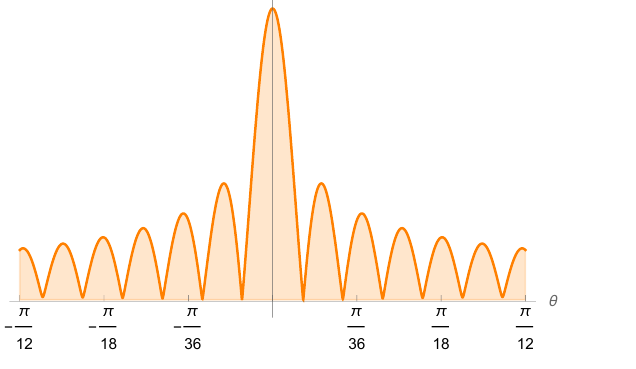
Figure 5 . The amplitude of |hOi| around the north pole at T = 1 /π and µ = 2 for ω = 75 . that hOi in eq. (3.17) can be replaced by hOi J O l